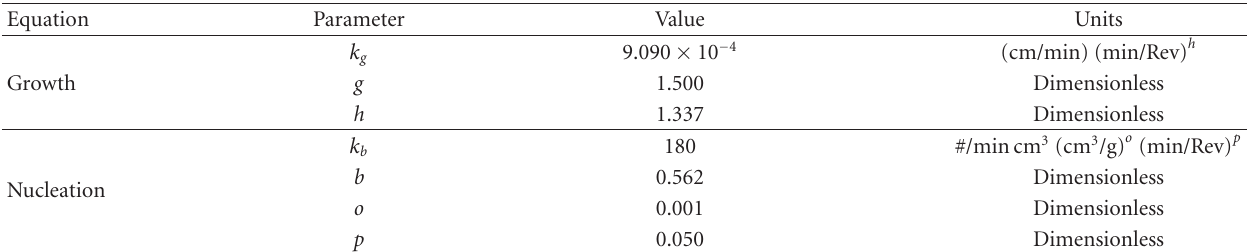
Table 1: Adjusted parameters for constitutive equations Salcedo-Estrada.